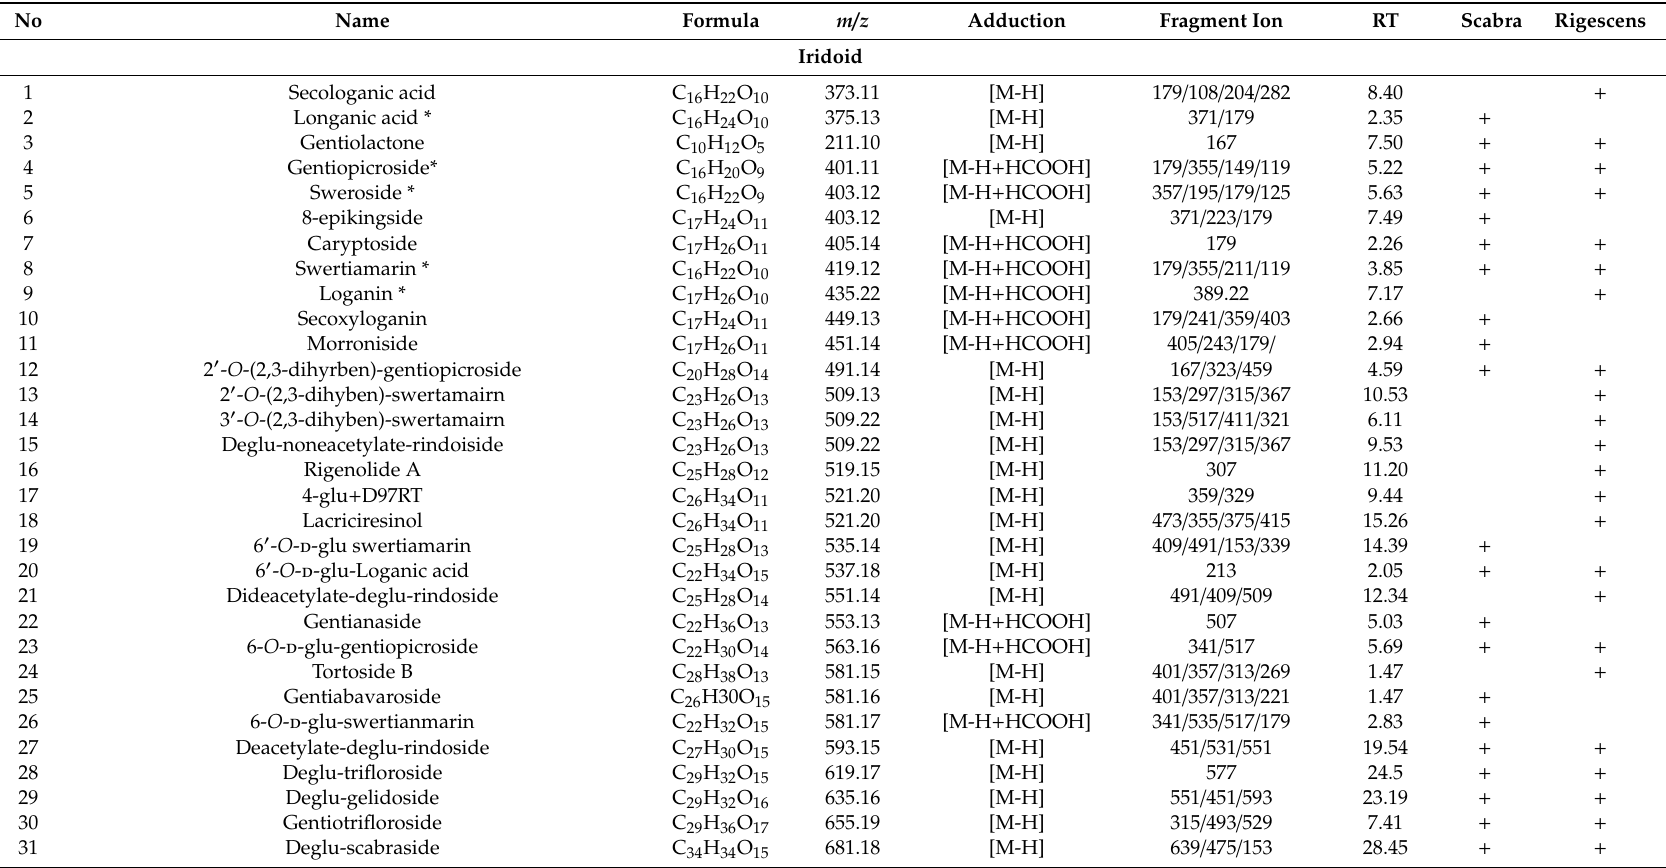
Table 1. Tentative characterization of chemical constituents of two species of GRR by UHPLC-LTQ-Orbitrap / MS in negative ion